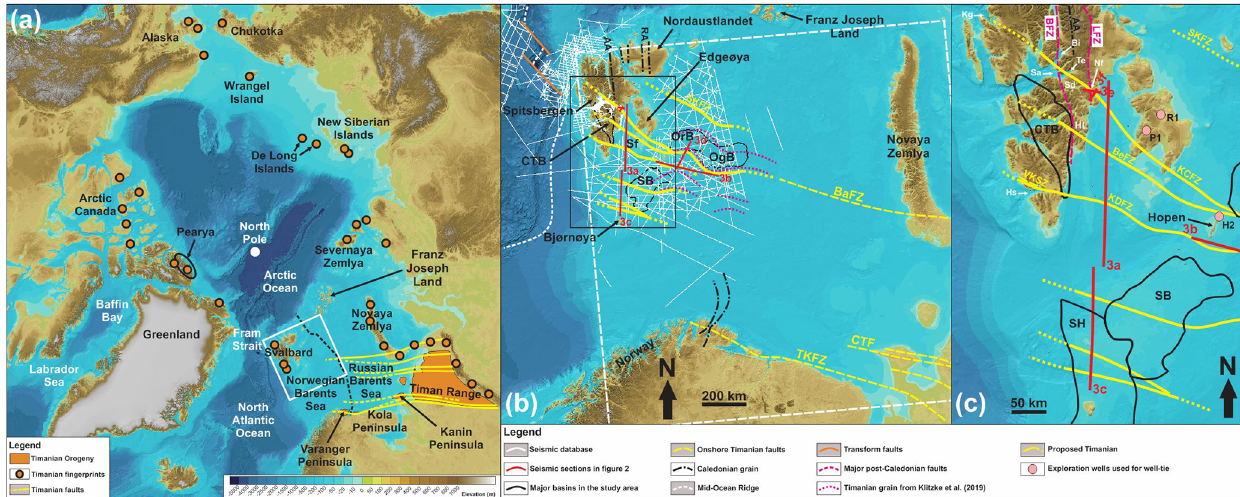
Figure 1. (a) Overview map showing the Timanian belt in Russia and Norway, as well as occurrences of Timanian fingerprints throughout the Arctic. (b) Regional map of Svalbard and the Barents Sea with the main geological elements and the seismic database used in the present study. The location of (b) is shown as a white frame in (a) . (c) Zoomed-in view of the northern Norwegian Barents Sea and Svalbard showing the main faults and basins in the study area, as well as the proposed Timanian structures. The location of (c) is shown as a black frame in (b) . The location of the Raddedalen-1 well is from Smyrak-Sikora et al. (2020). Topography and bathymetry are from Jakobsson et al. (2012). Abbreviations are as follows. AA: Atomfjella Antiform; BaFZ: Baidaratsky fault zone; BeFZ: Bellsundbanken fault zone; BFZ: